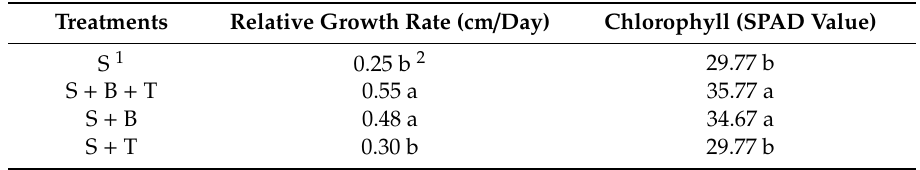
Table 3. E ff ect of individual and co-inoculation of Bradyrhizobium and Trichoderma on relative height growth and chlorophyll